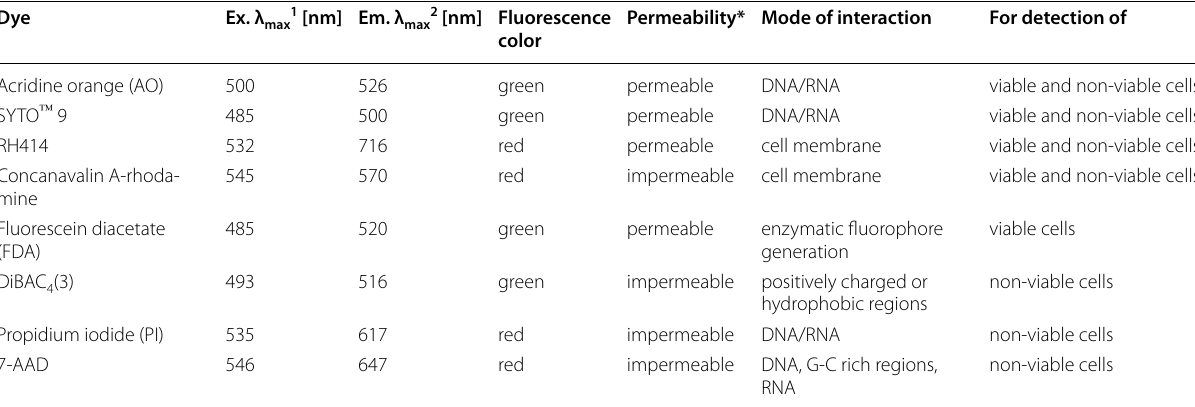
Table 1 Overview of the investigated fluorescent dyes